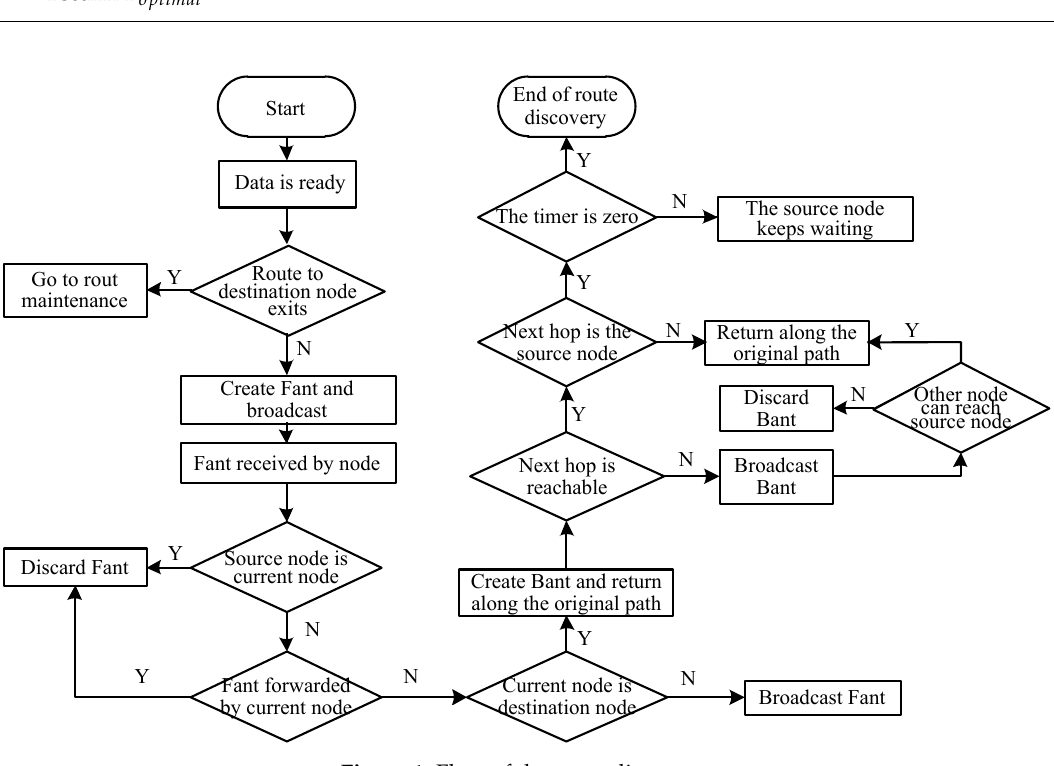
Figure 1. Flow of the route